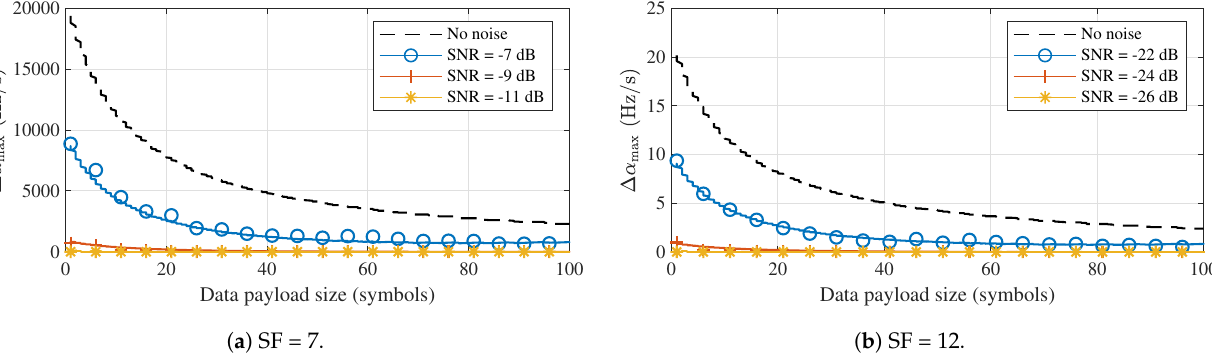
Figure 9. Lowest constant Doppler rate for which bit errors were observed ( ∆ α max ) for different data payload sizes. ( B = 125kHz).